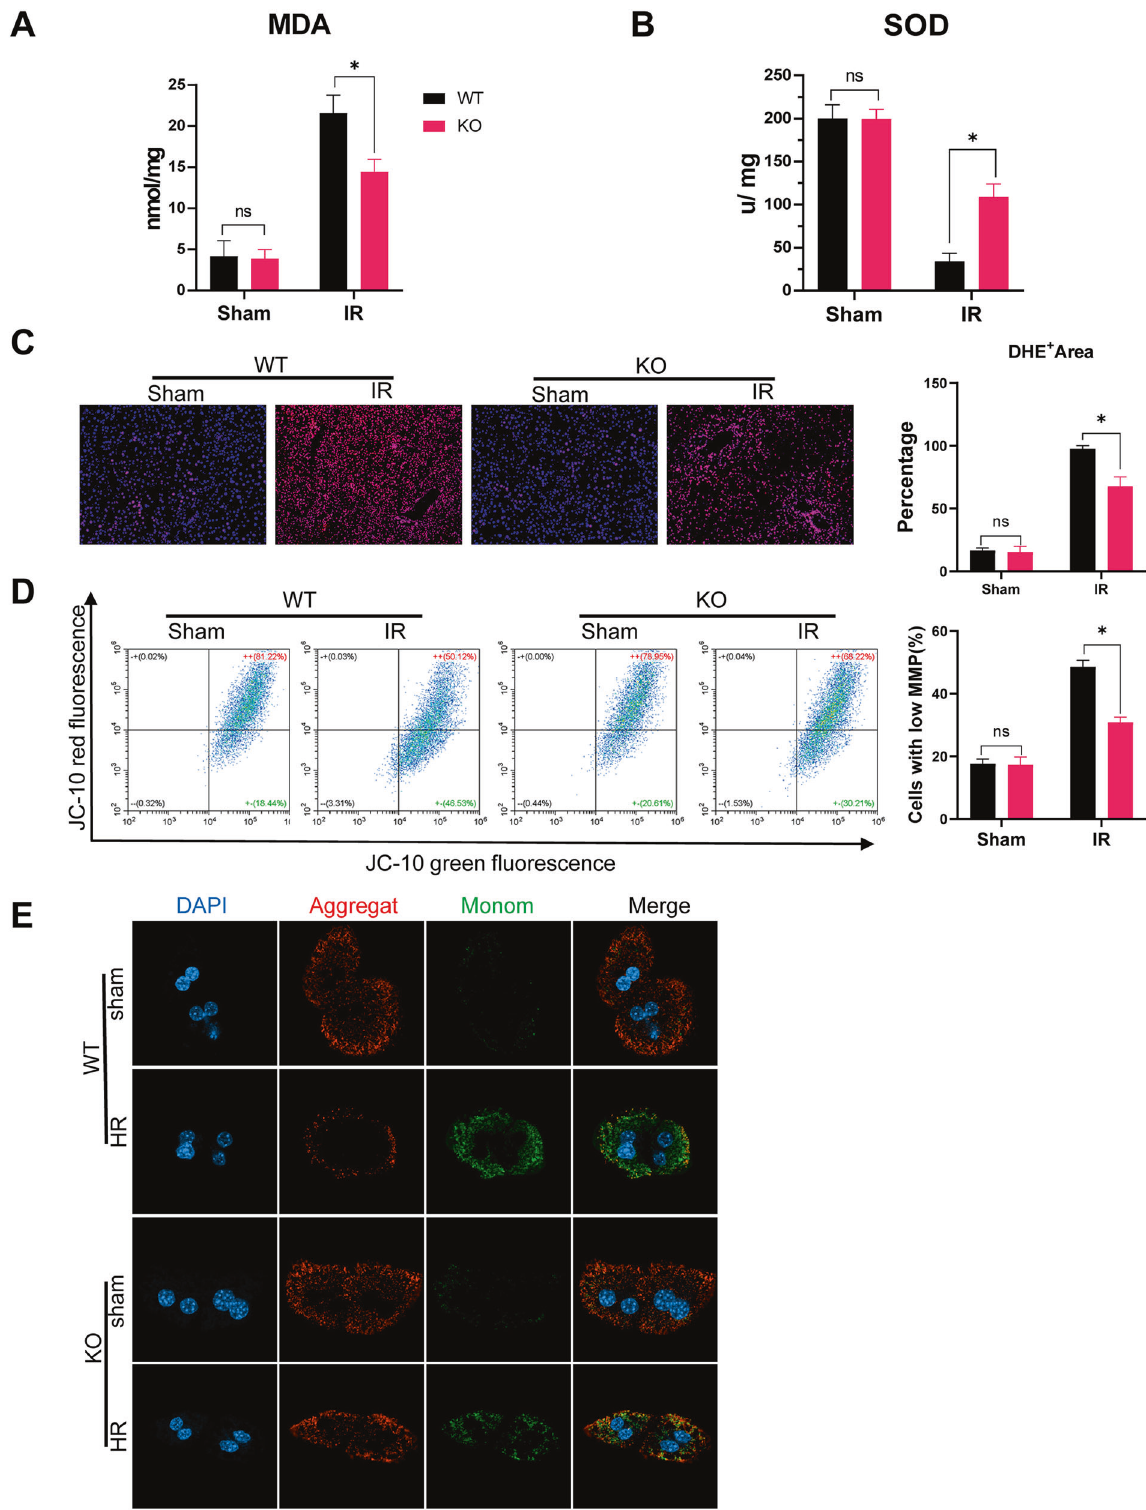
Fig. 4 MLKL de fi ciency attenuated hepatocellular injury by suppressing oxidative stress. WT and MLKL KO mice were subjected to liver IR model or sham procedure. Levels of MDA ( A ) and SOD ( B ) in liver tissues. C Representative images of DHE (red) staining in liver tissues. D MMP detected by fl ow cytometry analysis of JC-10 in isolated primary hepatocytes. Primary hepatocytes were isolated from WT and KO mice and subjected to H/R model as described in the section of methods. E MMP measured by JC-10 staining. J-aggregates (Red), J-monomer (Green). n = 5 mice/group. All results represent at least two independent experiments. Values were expressed as mean ± SD. * p < 0.05.